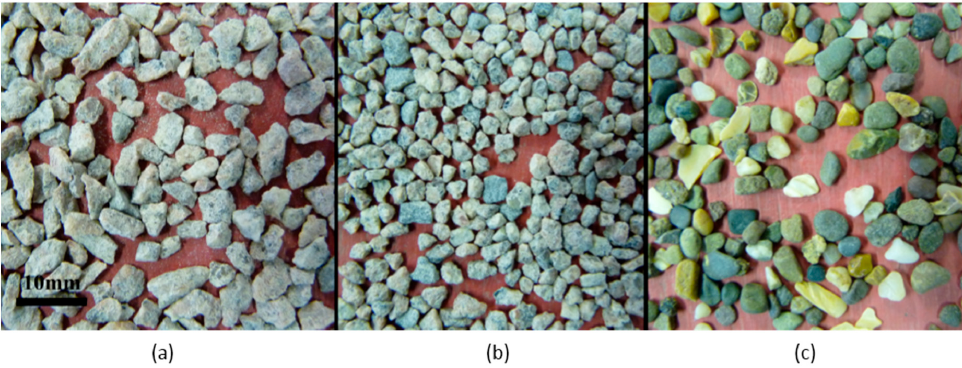
Figure 4. Images of 4–2 mm sand fractions ( a ) G-FEED ( b ) G-A ( c ) NS.